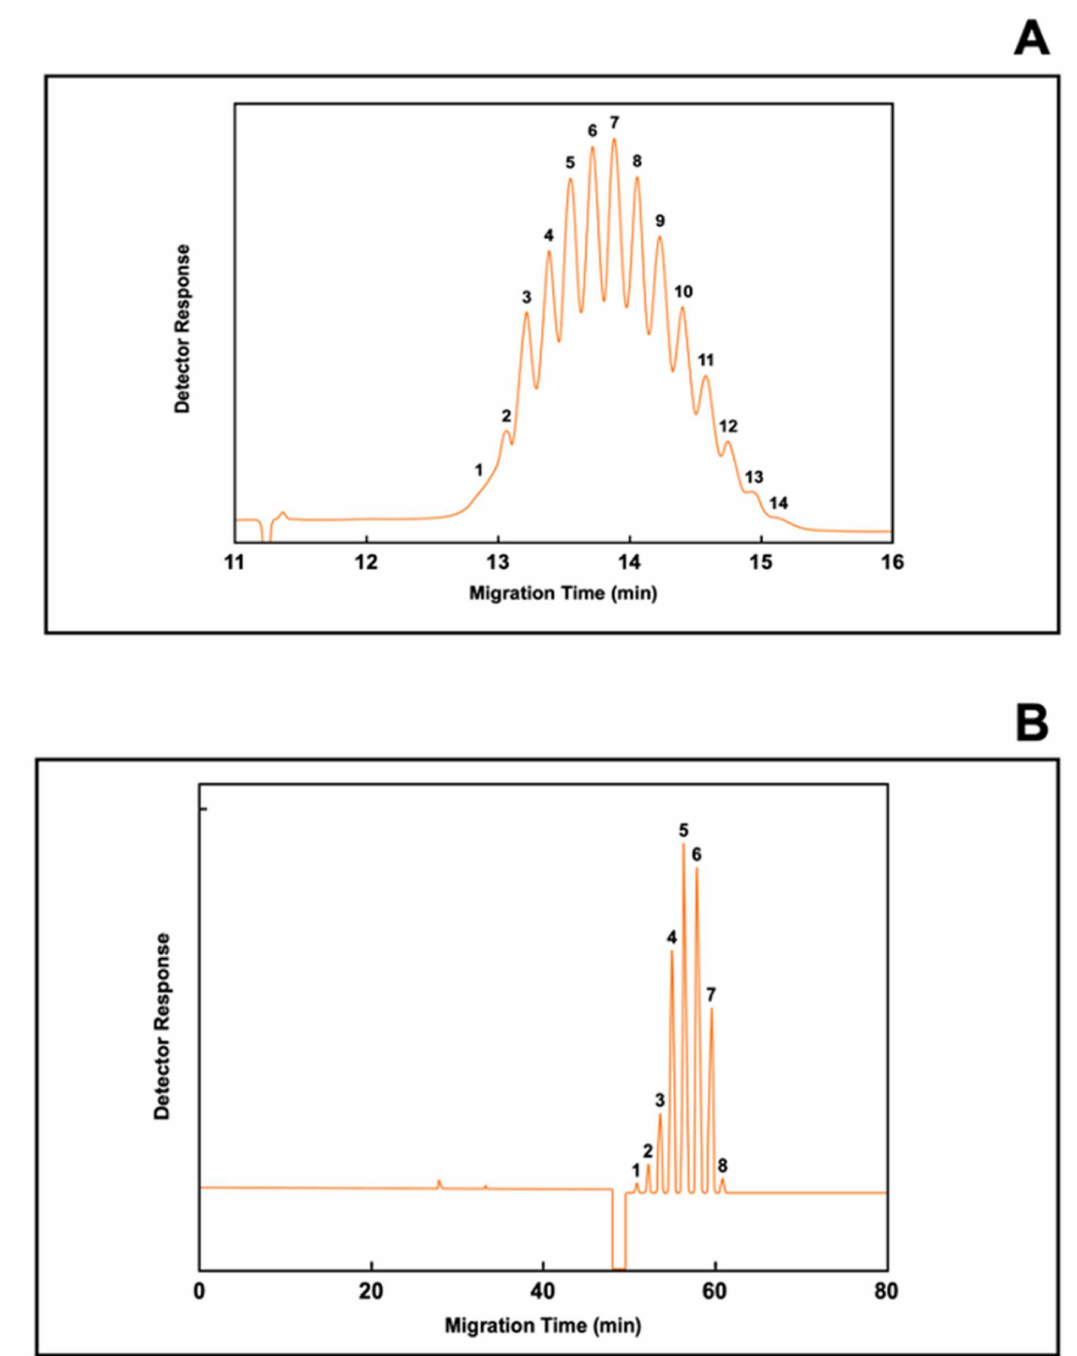
Figure 6. Depicts the electropherograms of 2 glycoproteins. ( A ) depicts an electropherogram of the various glycoforms of heparan-N-sulfatase separated by capillary zone electrophoresis (CZE). ( B ) depicts an electropherogram showing the various glycoforms of erythropoietin separated by CZE. Figures modified from